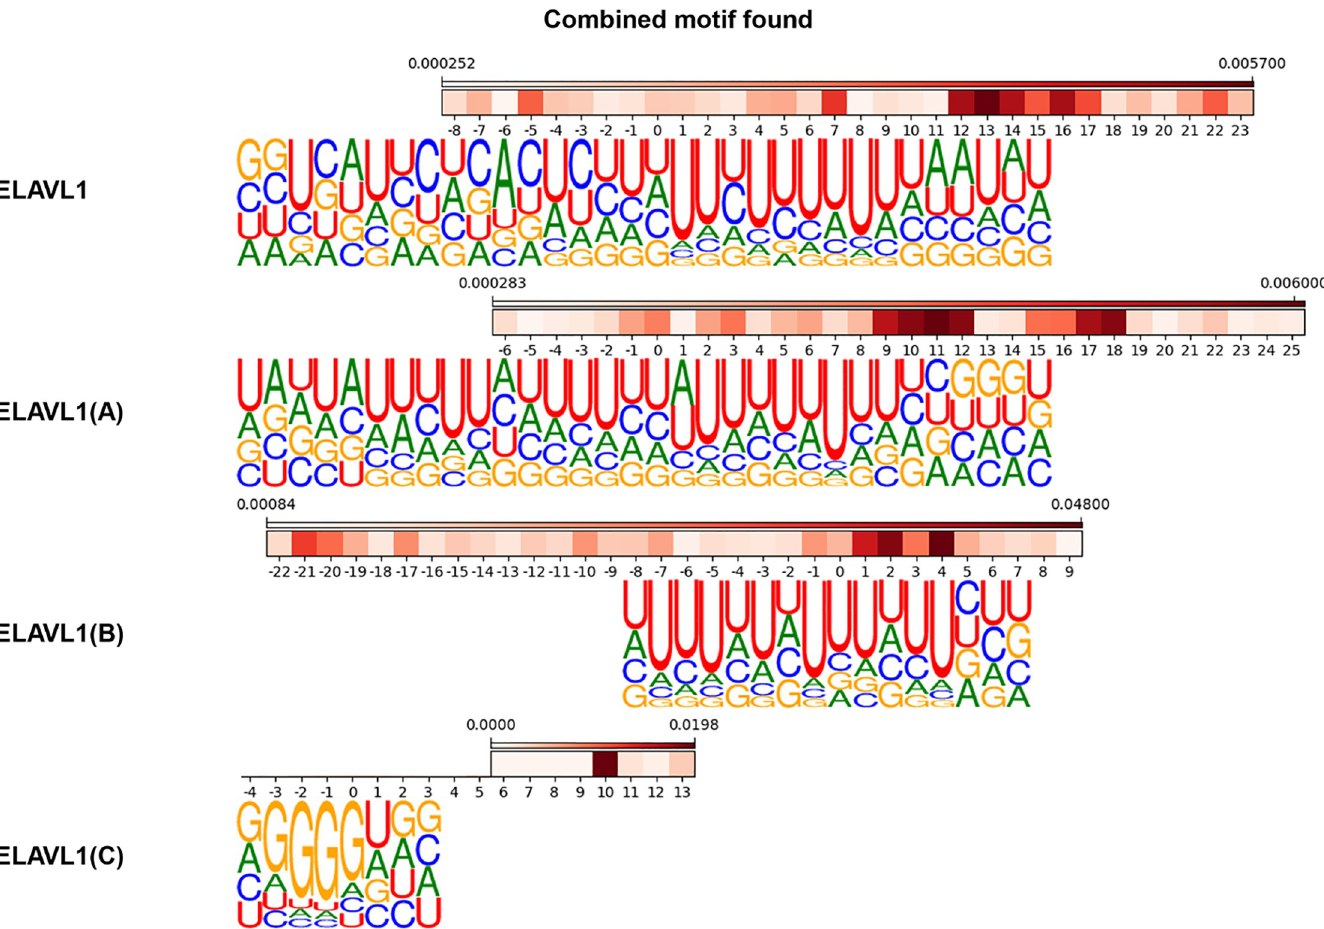
Fig 6. Combined motif analysis of ELAVL1 family. Aligned sequence motifs and structure motifs were shown for four different ELAVL1 family. Since we used weighted sum score for structure motif, values indicated in color bars are not structure forming probabilities but weighted scores. As the score is higher, a nucleotide is likely to participate in secondary